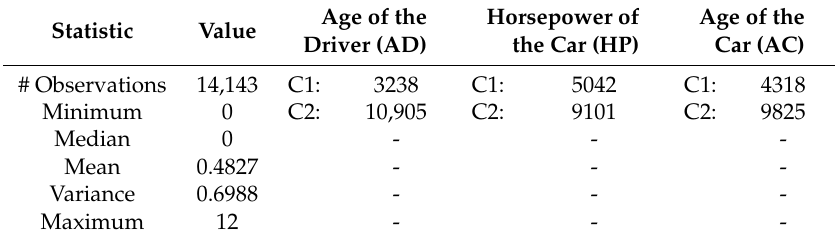
Variance 0.6988 - - - Maximum 12 - -